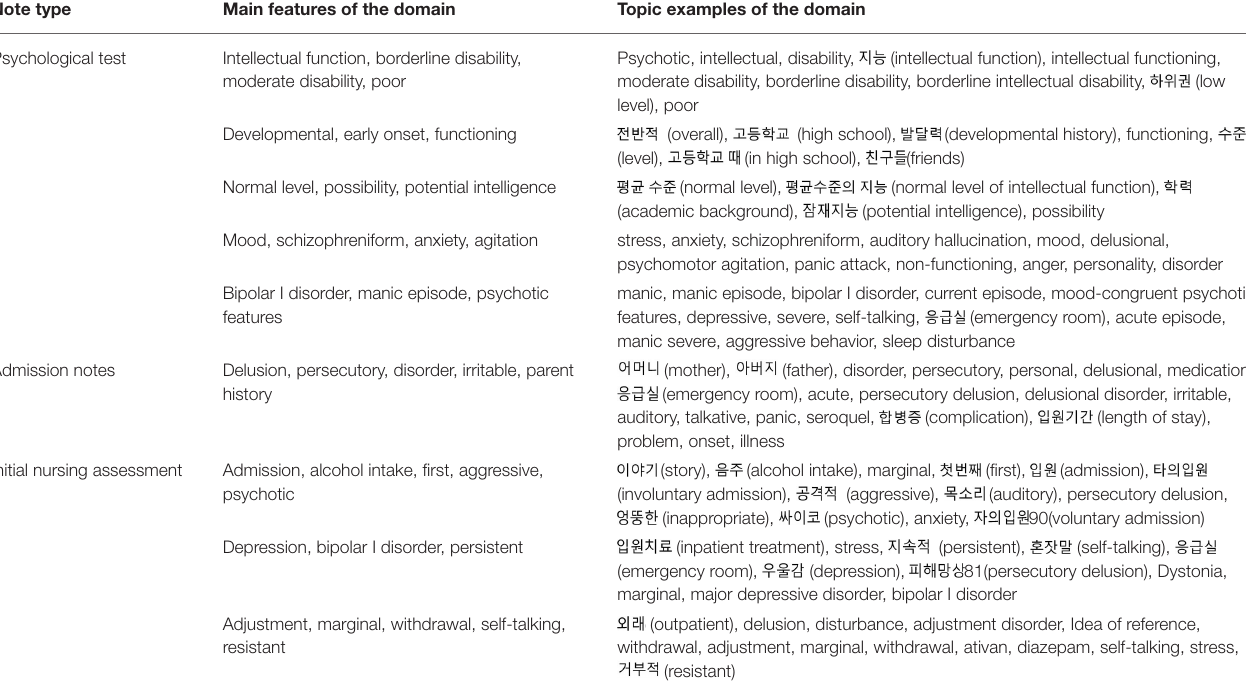
TABLE 2 | Domains selected by LASSO model in admission note, a note of psychological tests, and a note of initial nursing assessment.